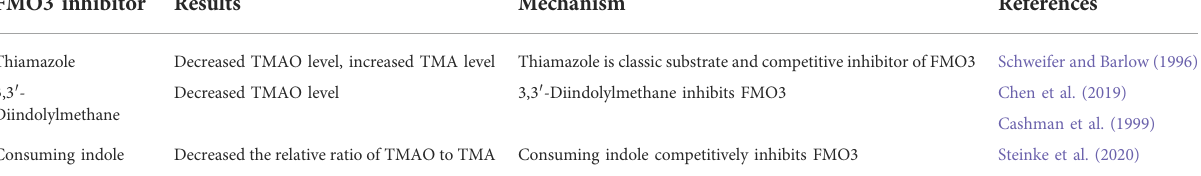
TABLE 3 Compounds that inhibit FMO3